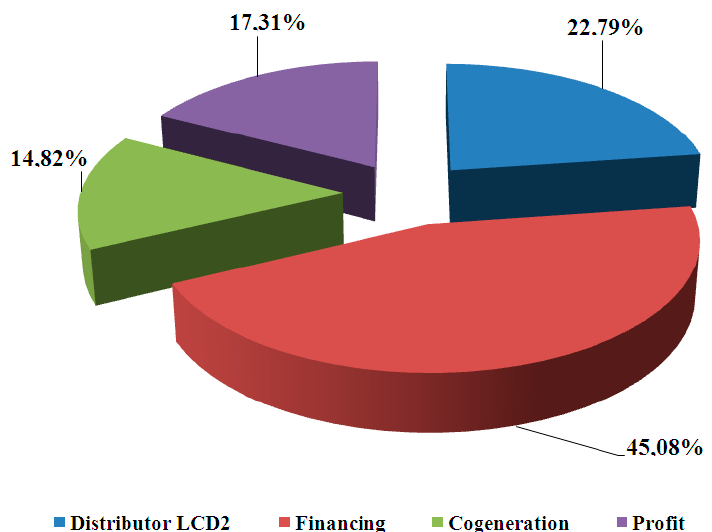
Figure 7. Composition of energy costs for company Figure 7. C omposition of energy costs for company A.